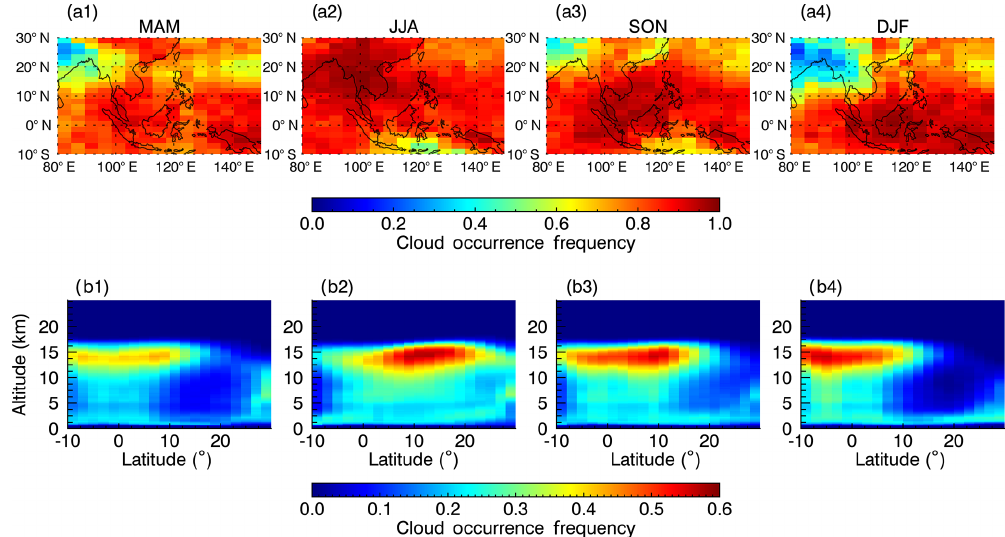
Figure 3. Cloud occurrence frequency derived from 2B-CLDCLASS-LIDAR, for (a1–a4) horizonal distribution and for (b1–b4) zonal latitude–altitude cross section. Table 3. Cloud occurrence frequency (%) derived from 2B-CLDCLASS-LIDAR. In the section ocean vs. land, the number outside paren- theses represents both land and ocean. The first number in parentheses is for ocean, and the second one is for land. In the section single vs. multiple cloud layers, the first number in parentheses represents single layer, and the second number is for multiple layer. Ice only Liquid only Mixed only Ice above liquid Ice above mixed Others All clouds Ocean vs. land